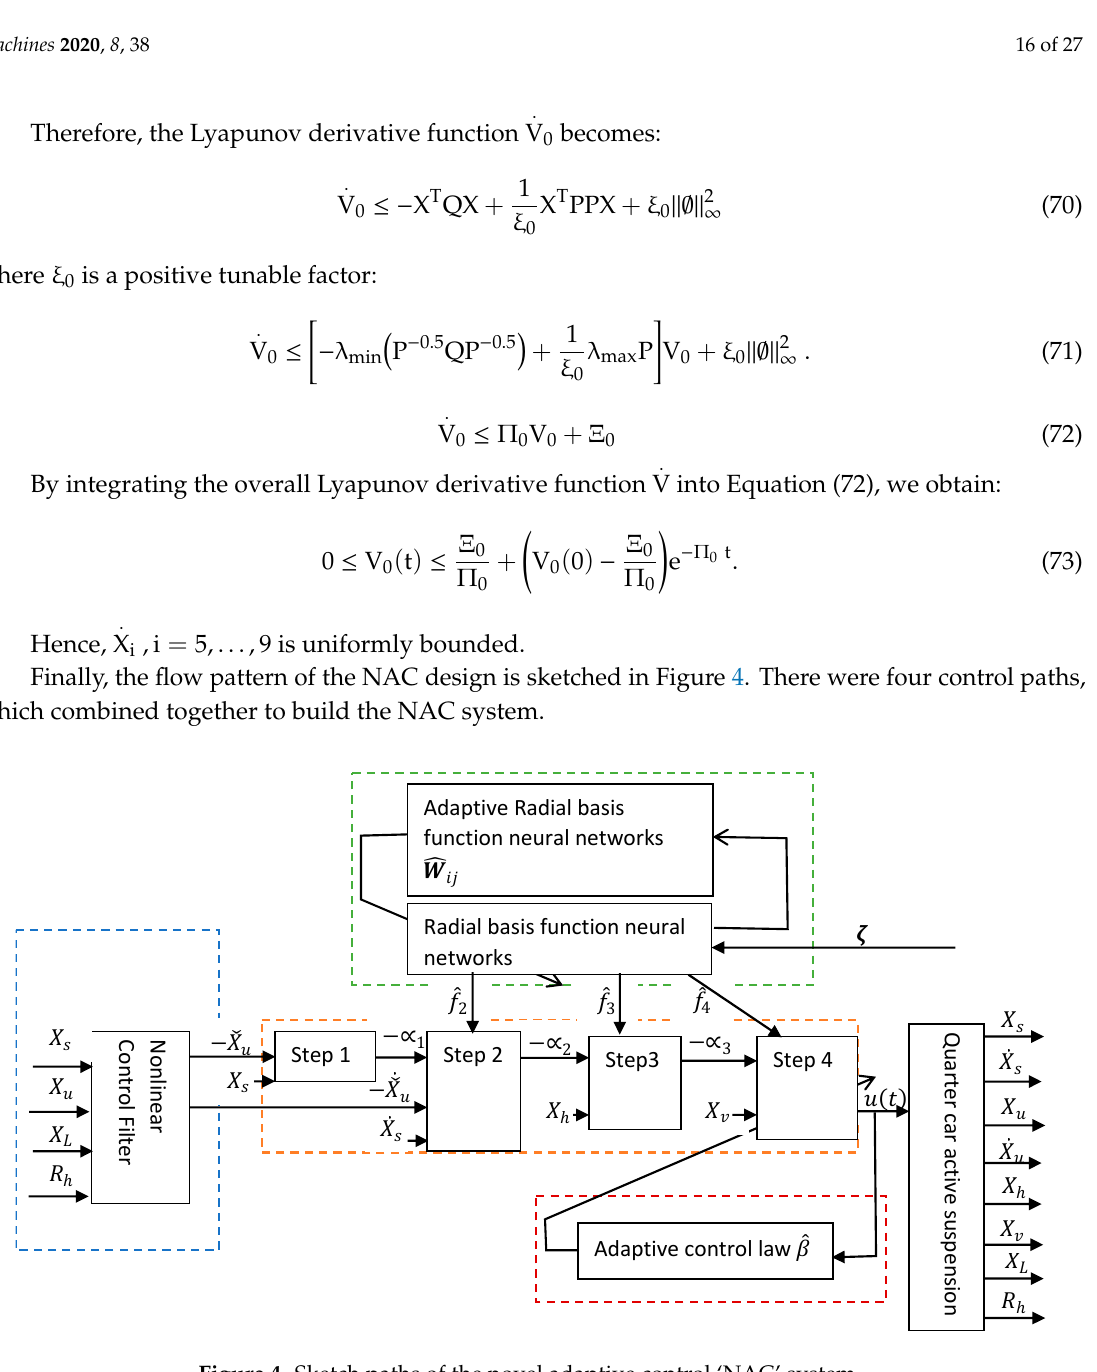
Table 2. Simulation data values of the active suspension mathematical model.